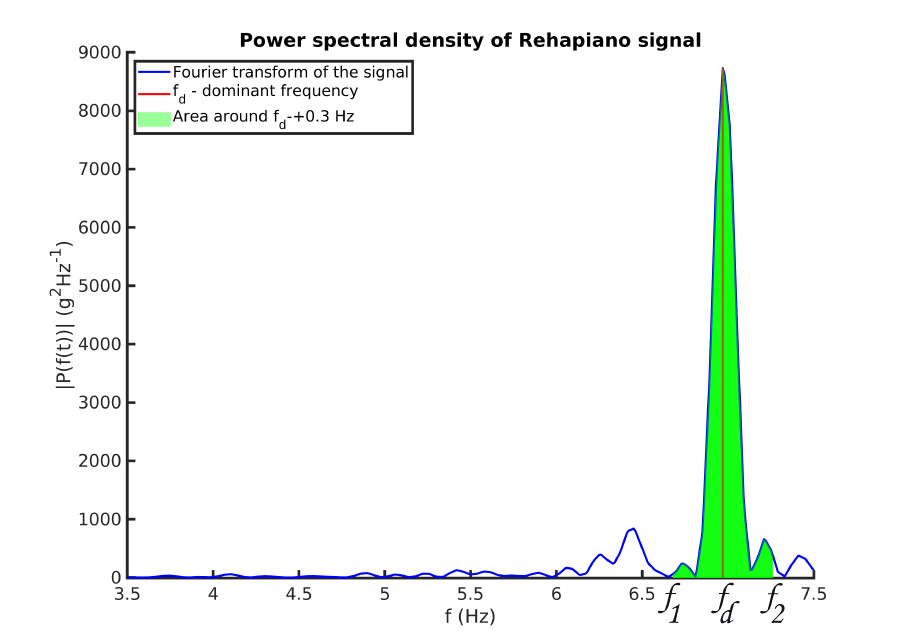
Figure 6. Power spectral density (PSD) of a PD patient measurement of a single finger. f d represents the dominant frequency of the